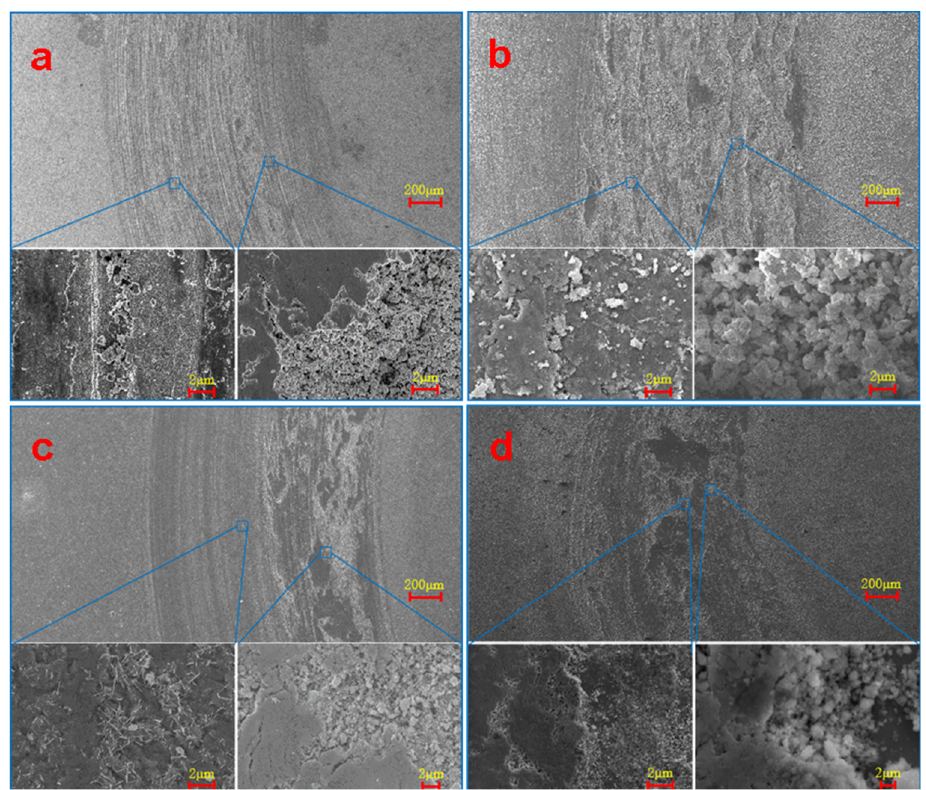
Figure 12. SEM images of the worn surface of BN coatings under different temperatures:( a ) 500 °C, ( b ) 600 °C, ( c ) 700 °C and ( d ) 800 °C.